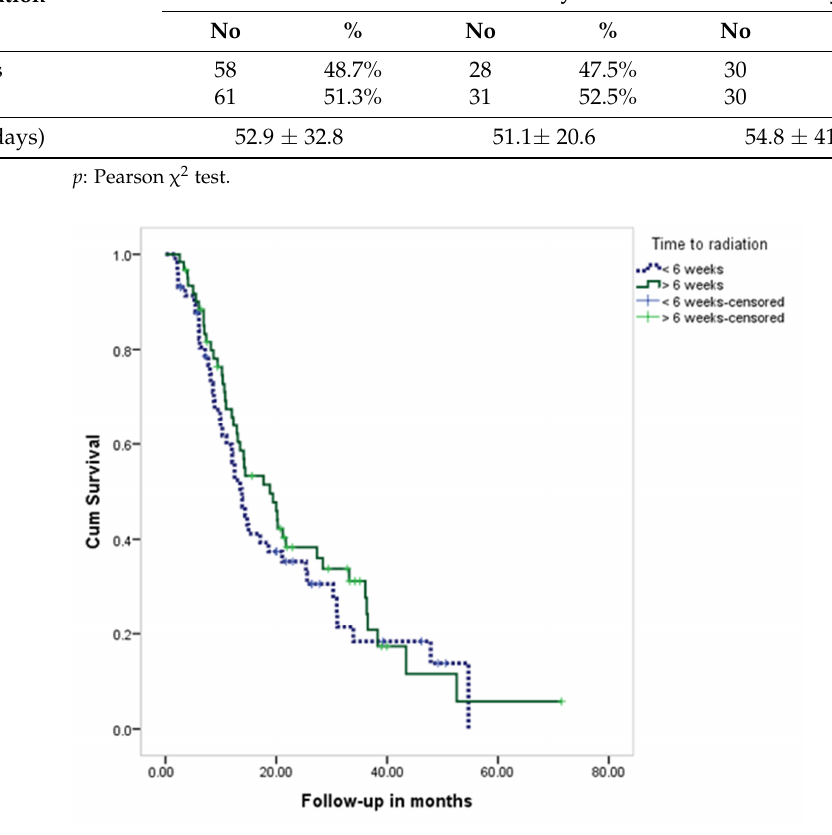
Table 5. Time to radiation in all patients, according to residence.